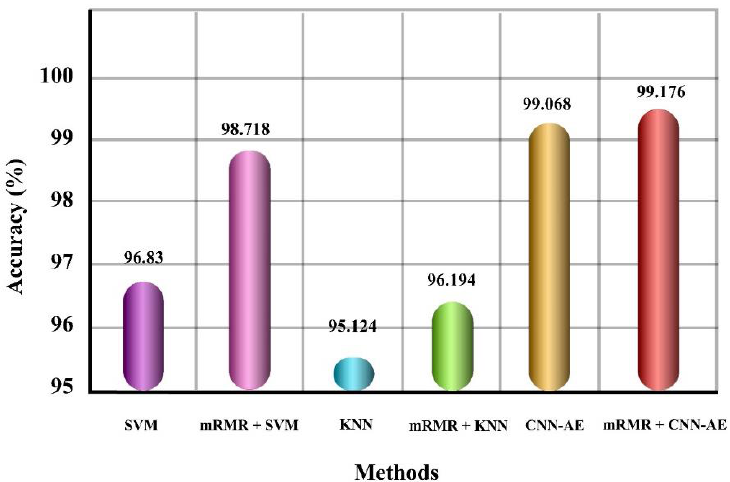
Figure 8. Results for the Freiburg dataset.